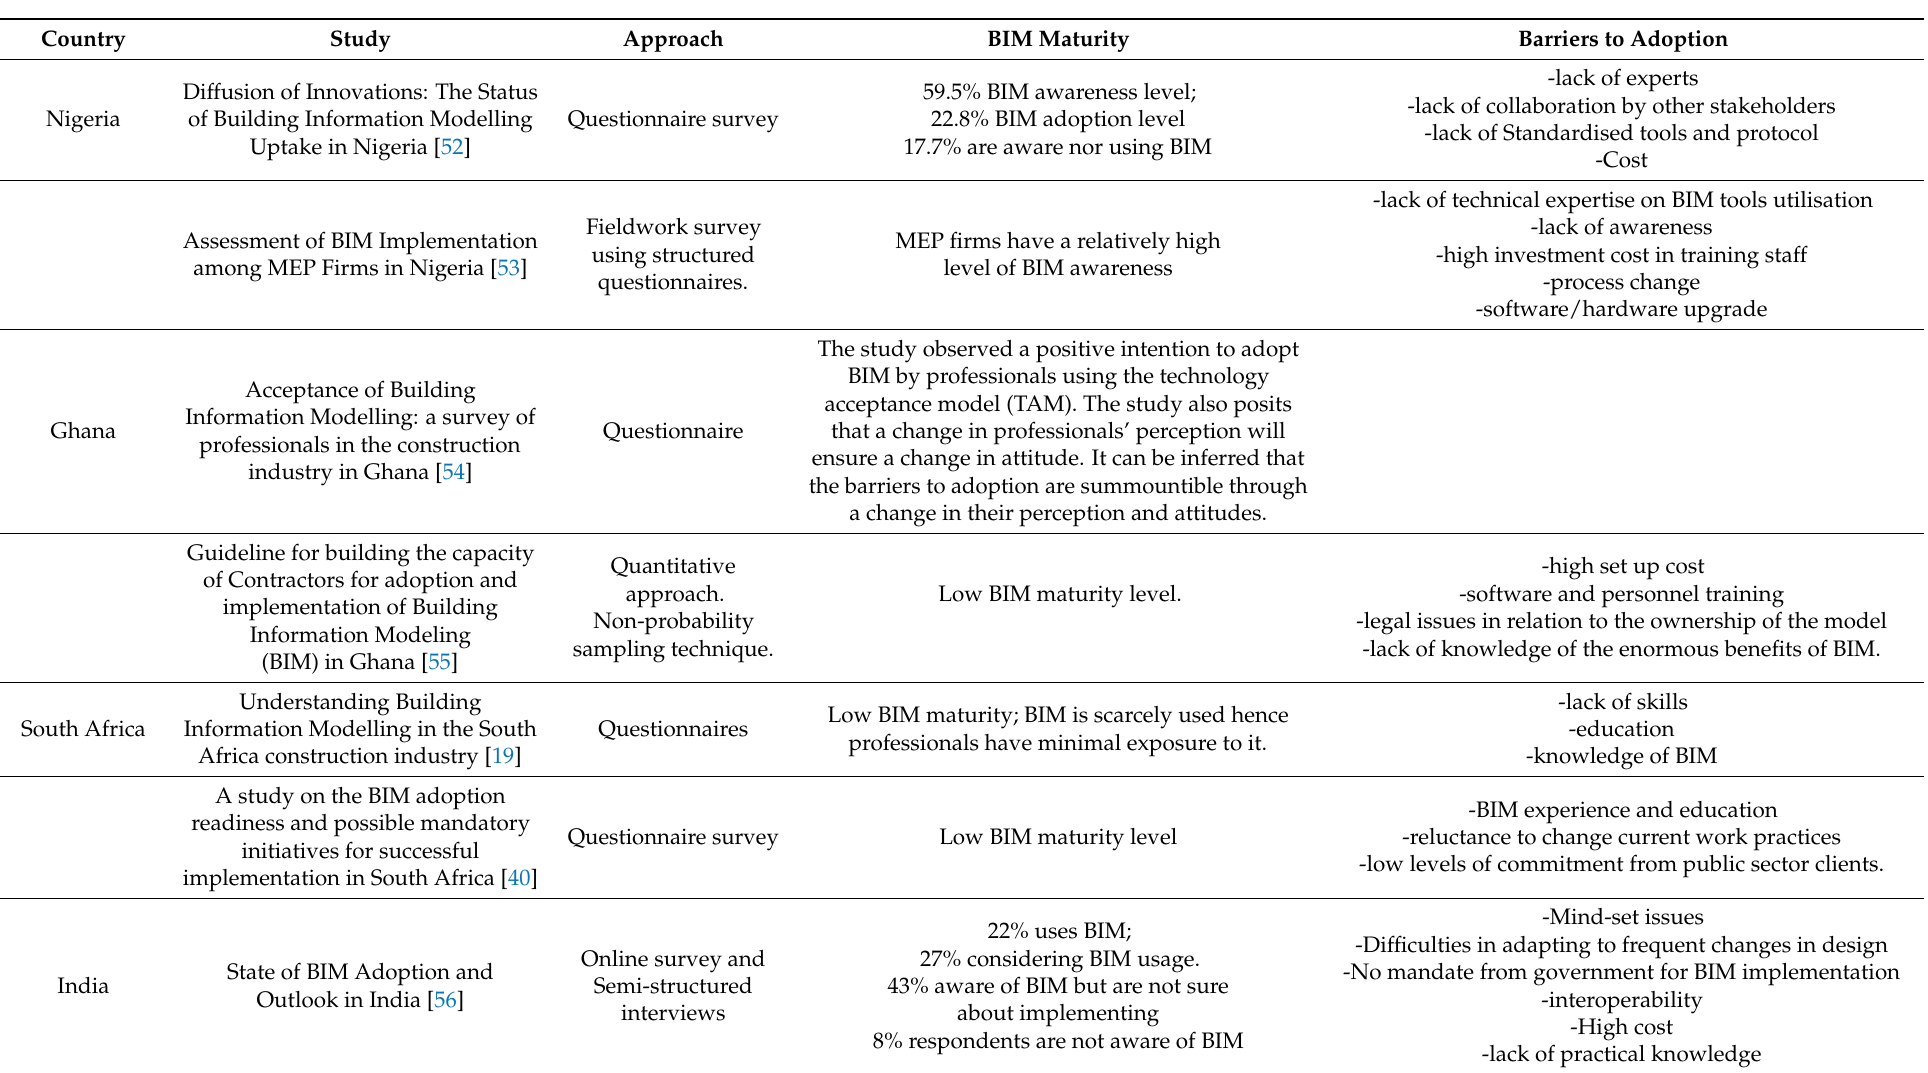
Table 2. Selected BIM studies in developing